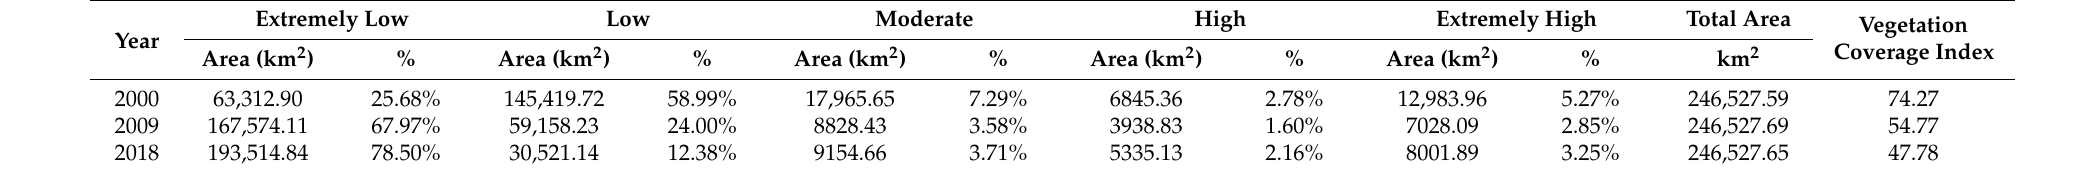
Table 6. Results of the vegetation coverage index in